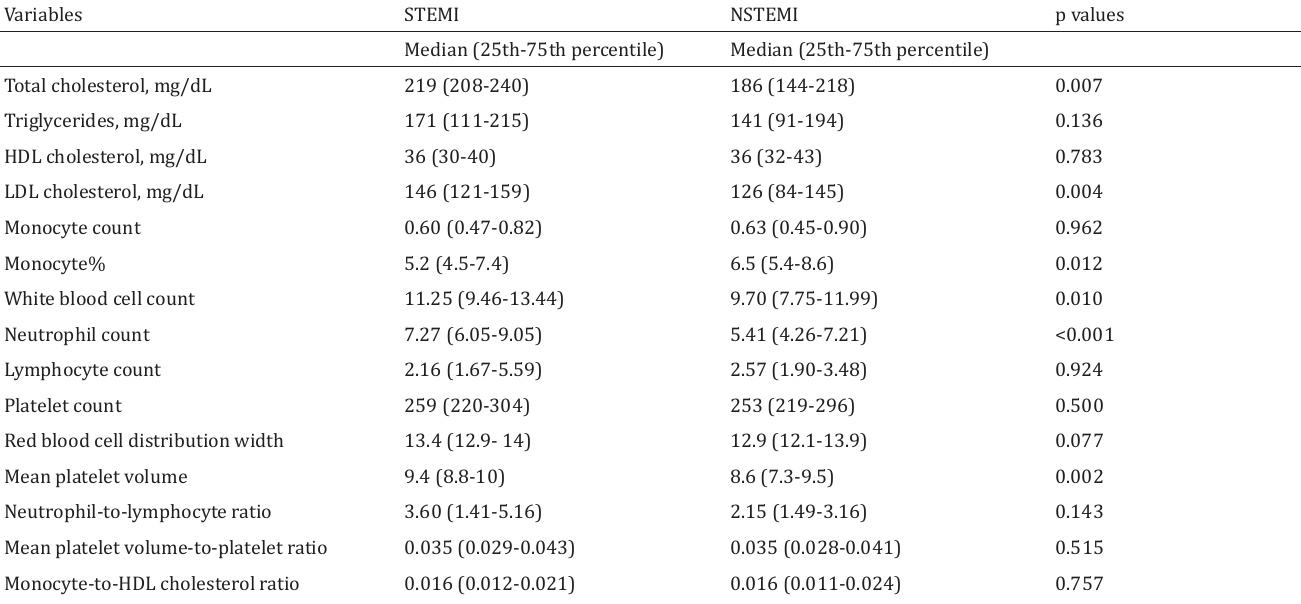
Comparison of the laboratory parameters between the STEMI and NSTEMI groups STEMI, ST-segment elevation myocardial infarction; NSTEMI, non-ST-segment elevation myocardial infarction; HDL, high-density